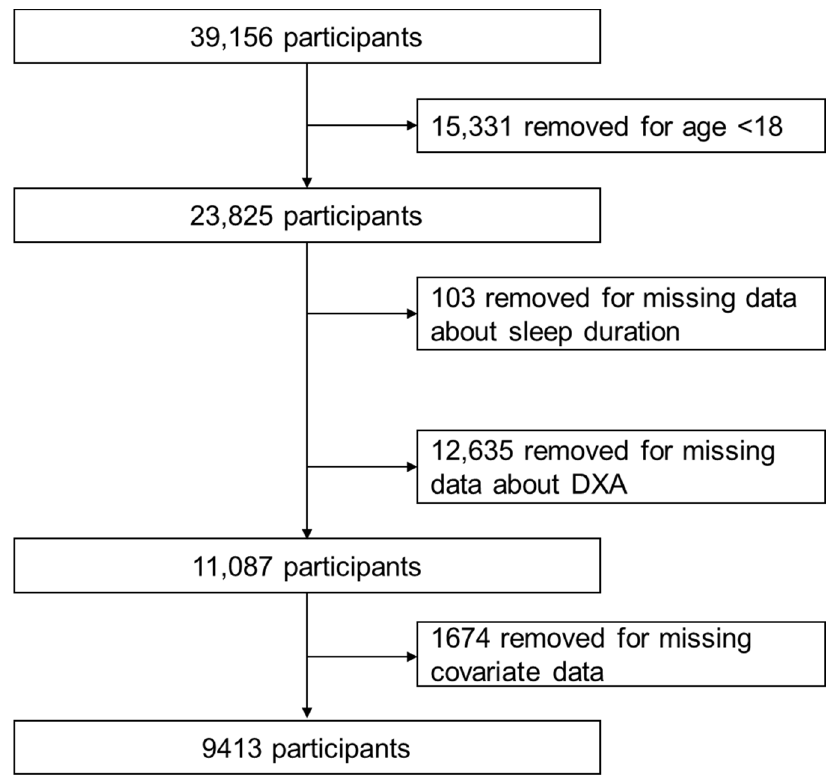
Figure 1. Flowchart of participants inclusion from NHANES 2011–2018.